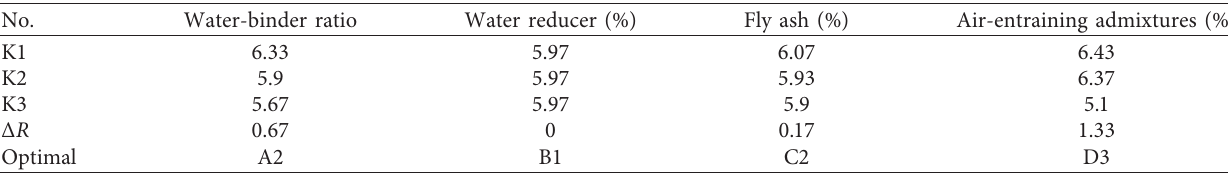
Table 8: The results of the extremum difference.